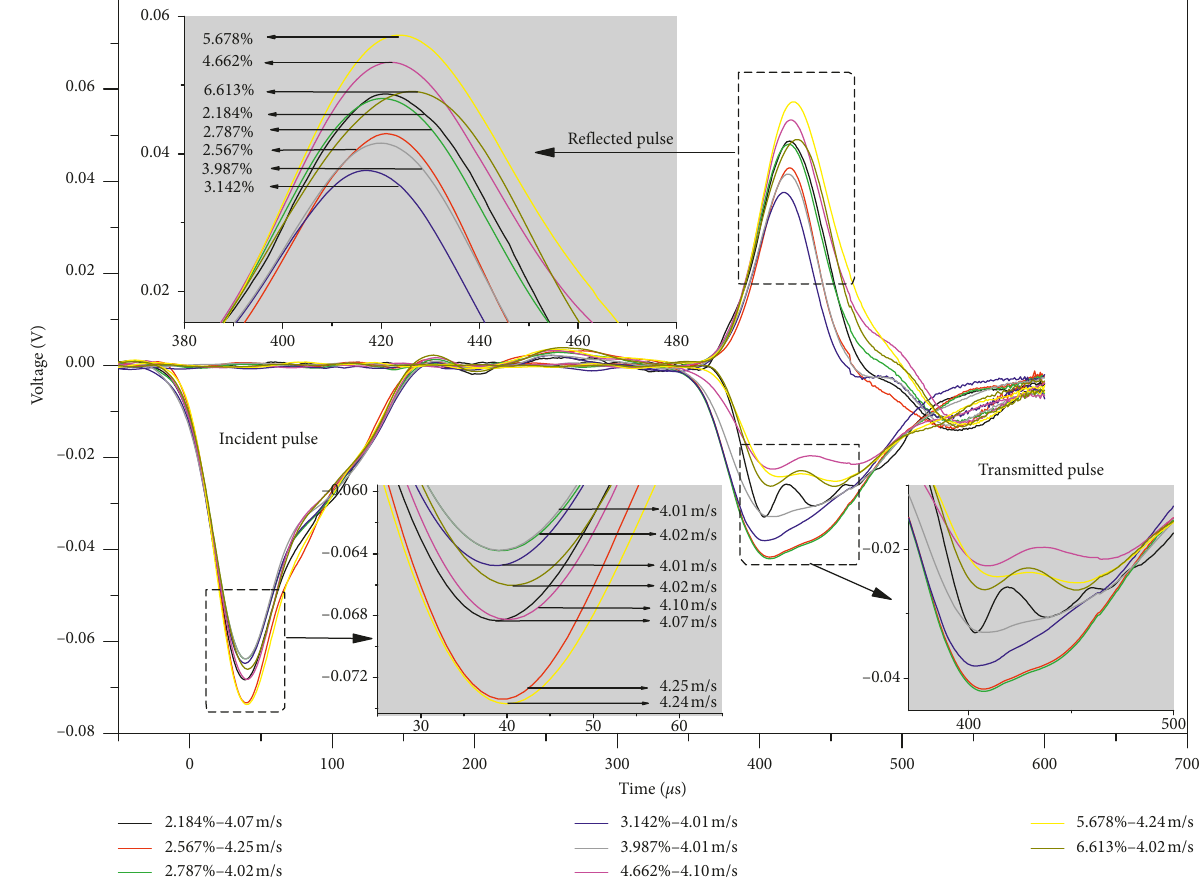
Figure 5: Waveforms of incident, reflected, and transmitted wave strain signals.